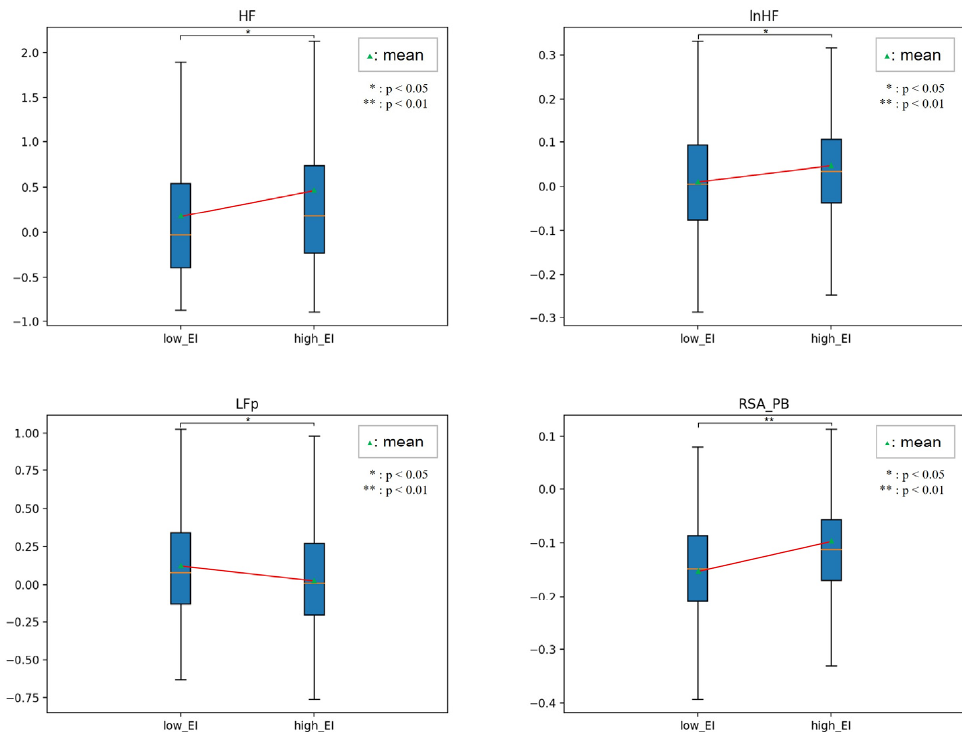
Figure 10. Comparison between low and high EI in HRV.